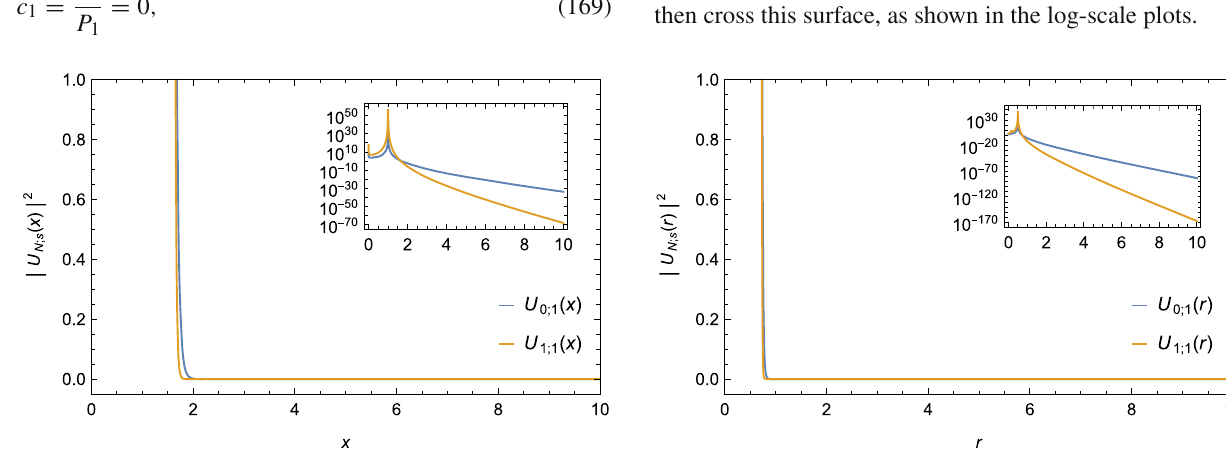
Fig. 13 (AdS) Case 2: a > 0. The first two squared QBS radial wave eigenfunctions as a function of the new radial coordinate x (left) and radial coordinate r (right); a = 0 . 20, R = 1, M = 0 . 2125. The units are in multiples of C N ;